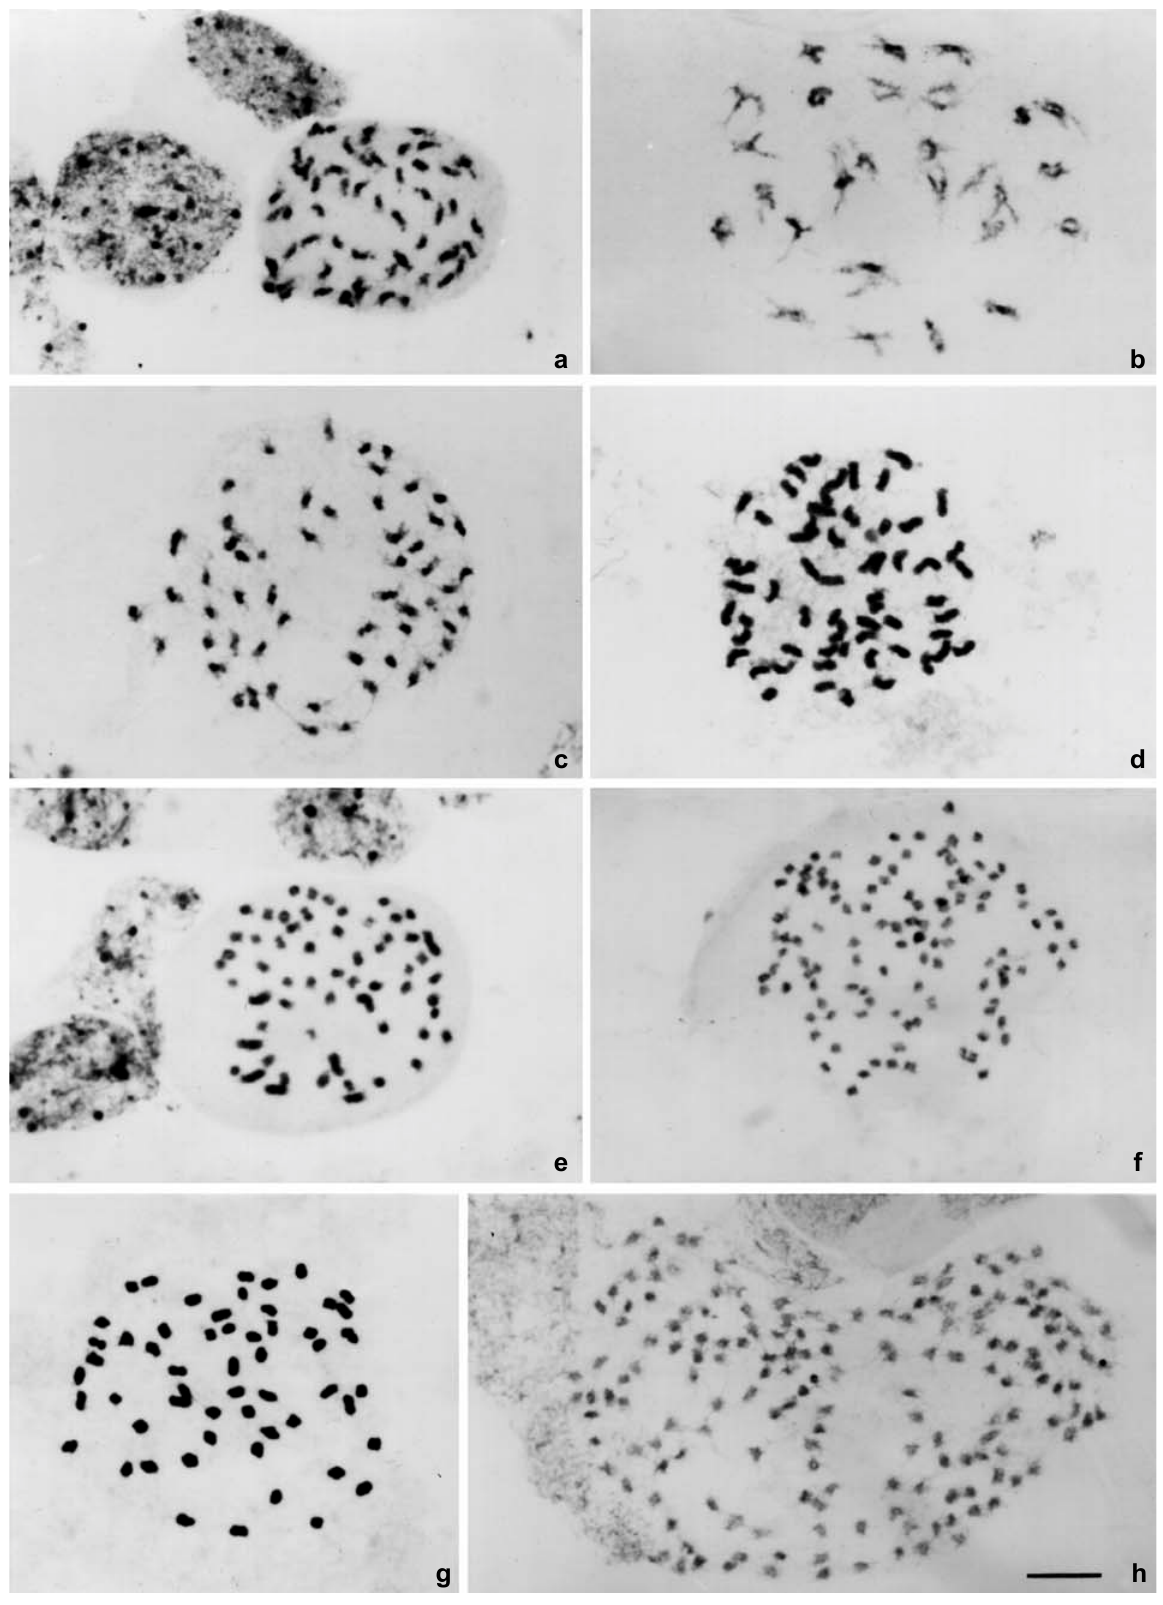
Figure 5 - Chromosome complements and interphase nuclei of Brazilian species of Oncidiinae: ( a ) Oncidium gravesianum (2n = 56); ( b ) diplotene of O. loefgrenii (n = 28 II ); ( c ) Oncidium paranaense (2n = 56); ( d ) Brassia lawrenciana (2n = 60); ( e ) Miltonia flavescens (2n = 60). Observe eight larger chromosomes; ( f ) diakinesis of Oncidium varicosum (n = 56 II ); ( g ) O. blanchetii (2n = ca. 112), and ( h ) O . aff. flexuosum (2n = ca. 168). Bar represents 10 µ